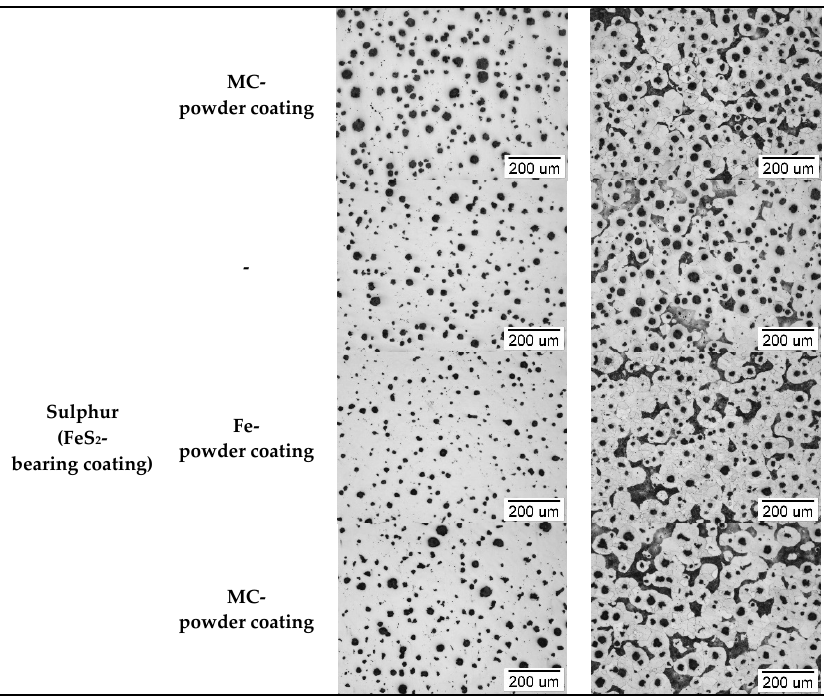
Figure 6. Typical structure characteristics in the casting body (unetched and Nital-etched).